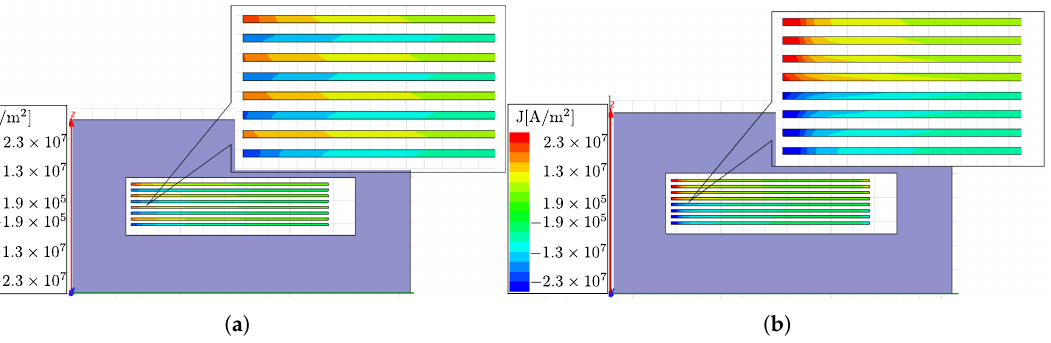
Figure 8. Comparison of current distribution in the ( a ) fully interleaving arrangement, and ( b ) non- interleaving arrangement. The color division of the current distribution result from the DC spirality effect, proximity effect, and skin effects. Reproduced with permission from [50], IEEE,